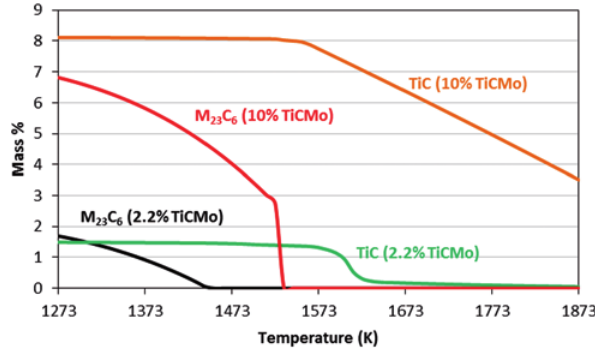
Fig. 17: Formation of different carbides at 1273–1873 K in Fe-Ti-C-Cr-Ni-Mo-Mn-Si-O-N-S